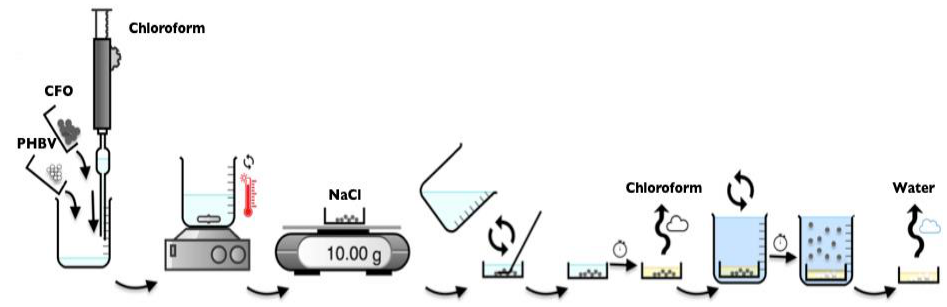
Figure 12. Schematic representation of the preparation procedure of the PHBV scaffolds.